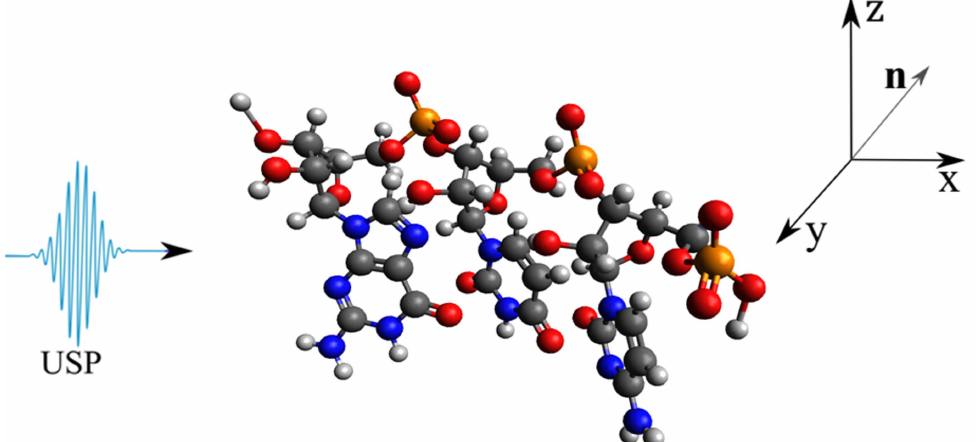
Figure 1. The CAG trinucleotide on which the USP falls is depicted, along with the selected coordinate system. The scattering spectra were calculated in the spatial orientation of the CAG with respect to the USP in the selected coordinate system shown in this figure. The red balls are oxygen atoms ( O ), the yellow ones are phosphorus ( P ), the blue ones are nitrogen ( N ), the light grey ones are hydrogen ( H ) and the dark grey ones are carbon ( C ).